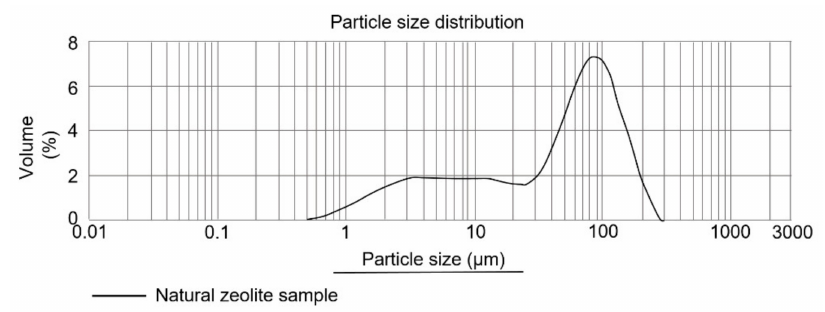
Figure 7. Particle size distribution vs. zeolite sample volume.